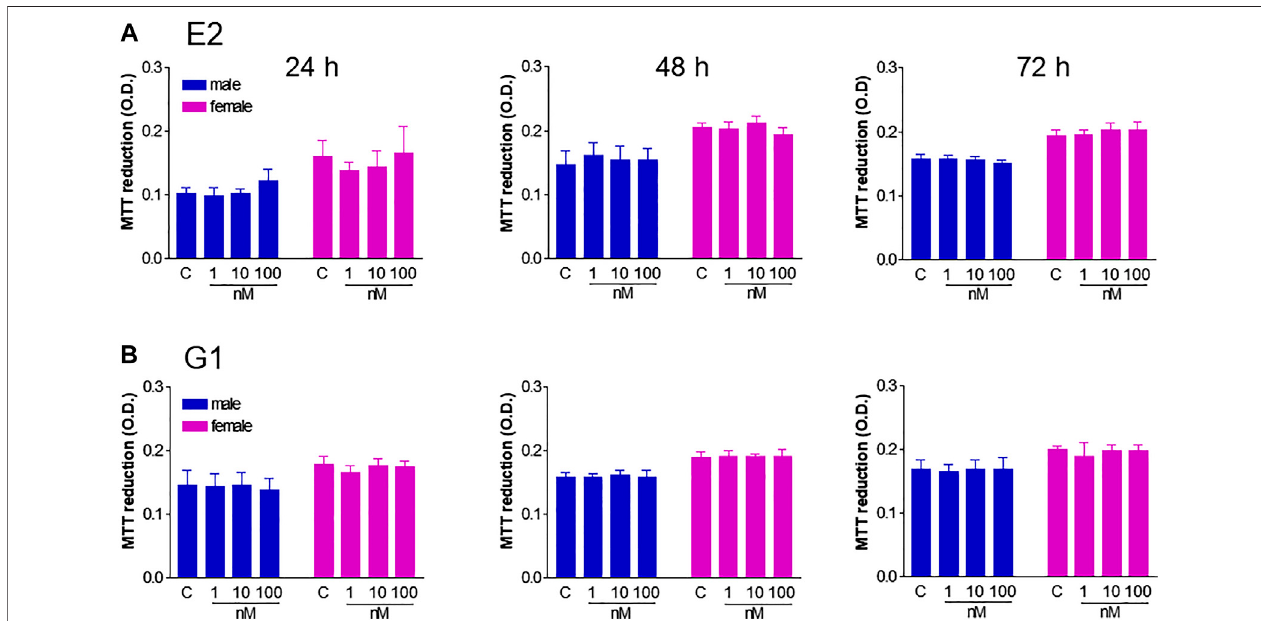
FIGURE 3 | Effect of E2 and G1 on HUVEC viability. HUVECs from male (blue) and female (pink) donors (5 × 10 3 cells/well) were grown in phenol red-free M199 medium supplemented with 5% FBS in the presence of ECGS (0.1 mg/ml) and heparin (100 UI/mL) until con fl uency, and treated with E2 (1 – 100 nM, panel A) , G1 (1 – 100 nM, panel B) or vehicle (C) for 24 – 72 h. Cell viability is shown as absolute optical density (O.D.) values (MTT assays). Each independent experiment ( n (cid:1) 4) was performed in triplicate using cells from 1 male and 1 female donor. Data represent mean ± SEM. t -test vs. control;